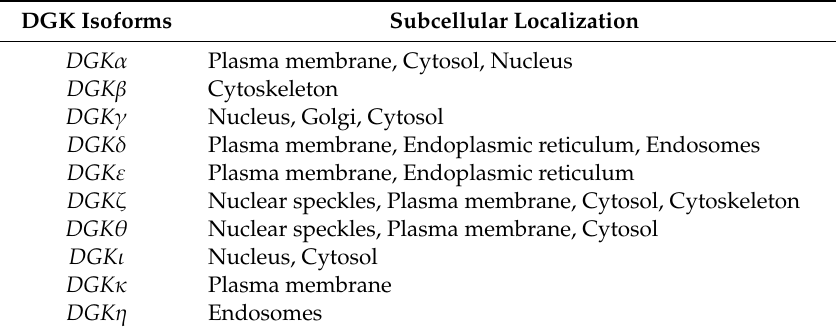
Table 1. Distribution of DGKs across distinct subcellular